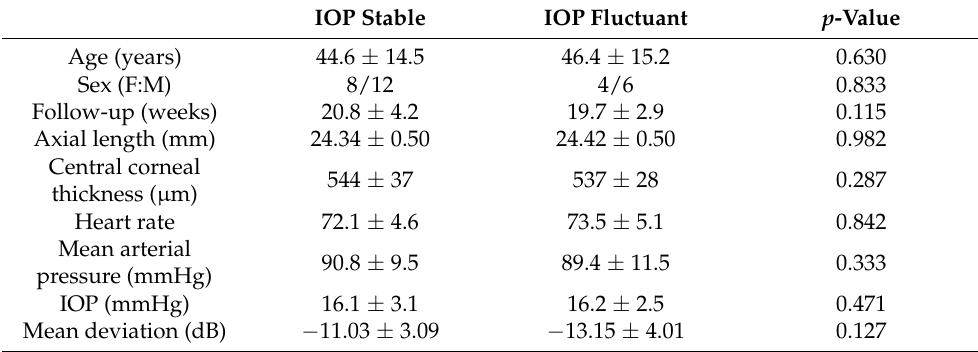
Table 2. Demographic of POAG subjects.